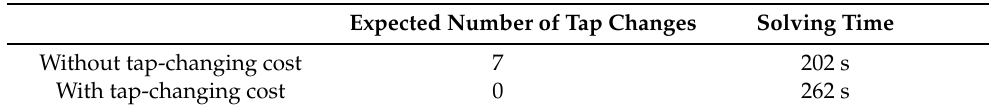
Table 1. Results on tap-changing.